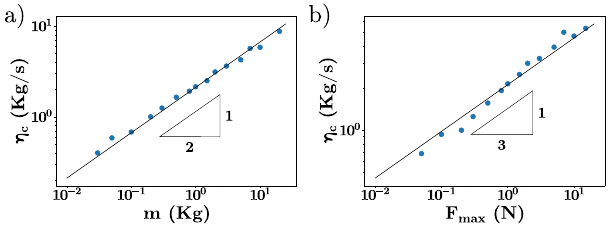
Fig. 4 Numerical scaling of the critical dissipation η c . The two physical parameters analyzed are a the masses m and b the maximum amplitude of the external load F . The lines show the scaling η c / m 1 = 2 F 1 = 3 max